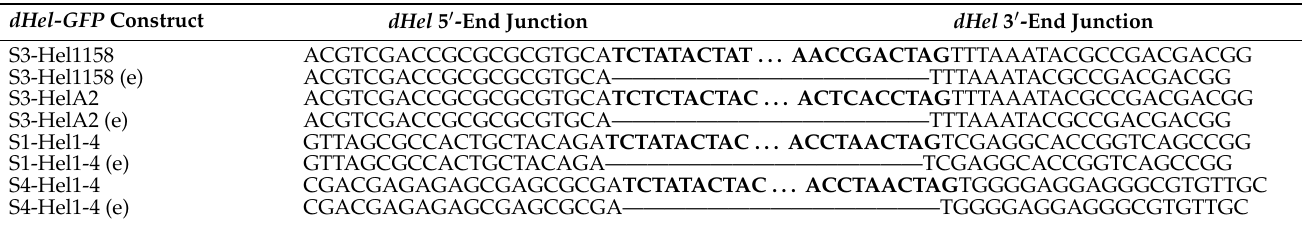
Table 3. Sequence of full and empty sites from dHel-GFP